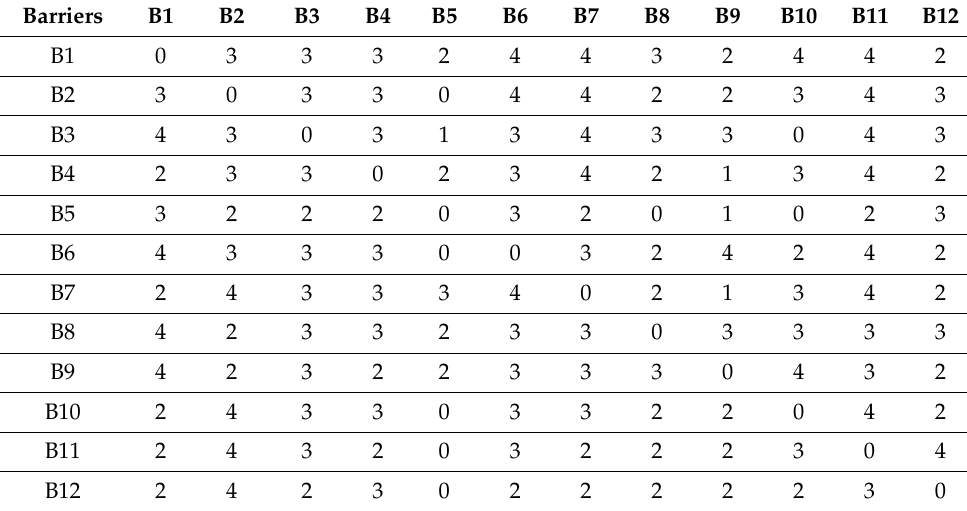
Table 5. Generating the direct-relation matrix (A). Barriers